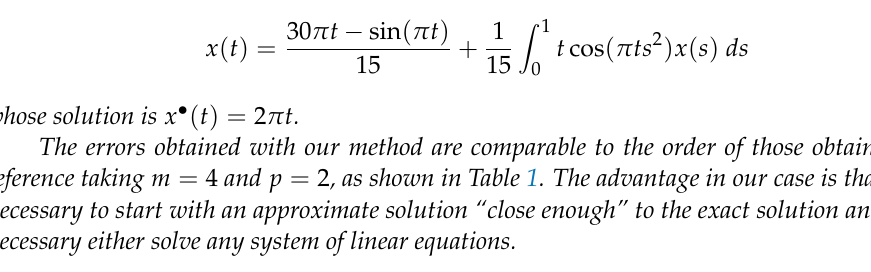
Table 1. (cid:107) x • − x ( n , r ) (cid:107) for Example 1 using the usual basis in C [ 0,1 ] . n r = 9 r = 17 r = 33